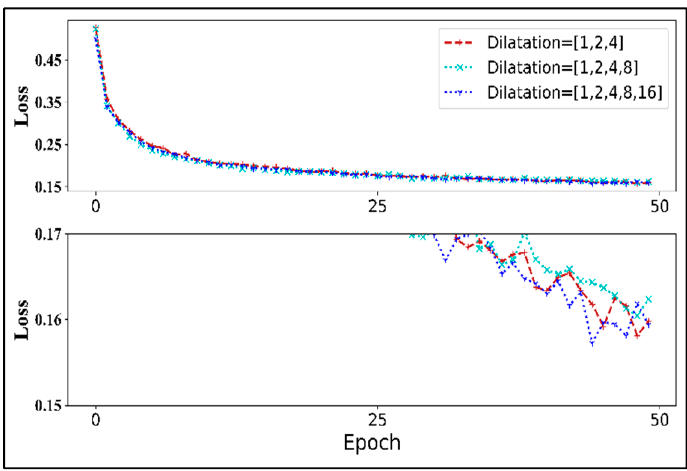
Figure 7. Convergence error of cost function with three sets of dilatation coefficients.